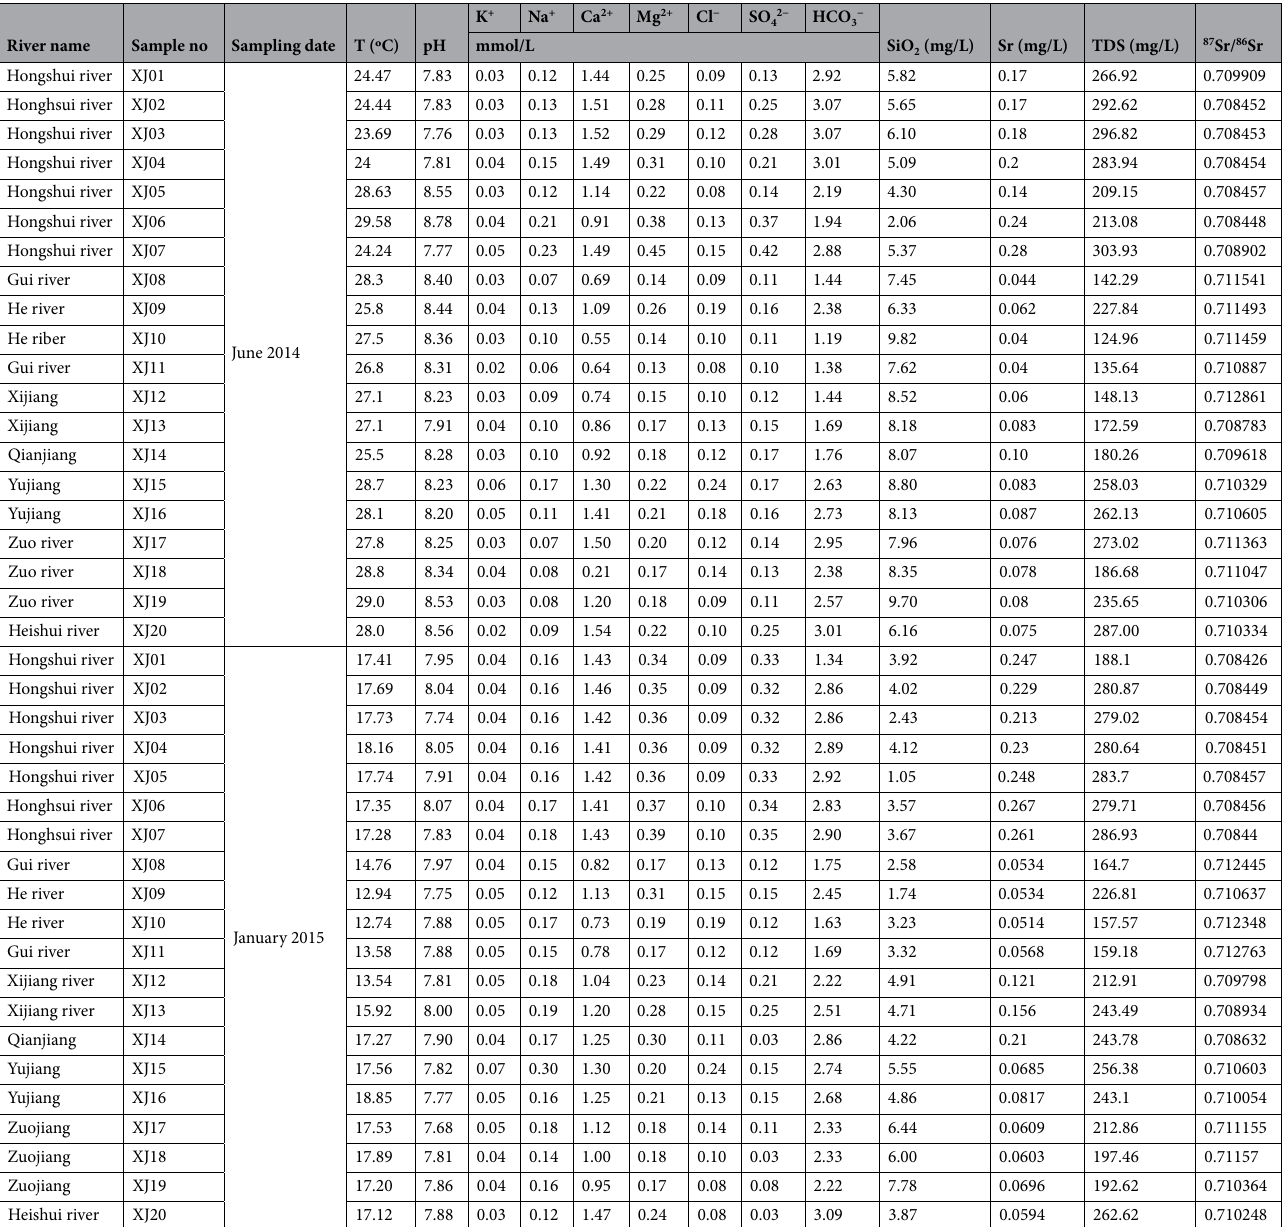
Table 3. Chemical compositions of the main ions at each sampling point of the mainstream and tributaries of Xijiang River.